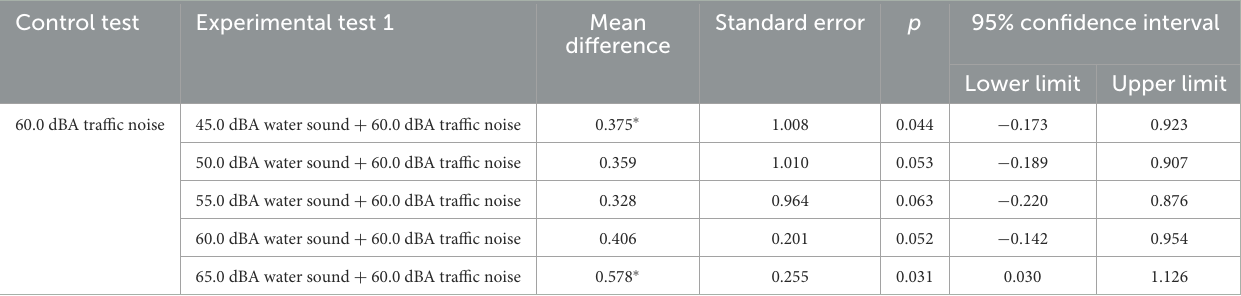
TABLE 3 Comparisons between the psychological health values on the cognitive dimension in the control test and experimental test